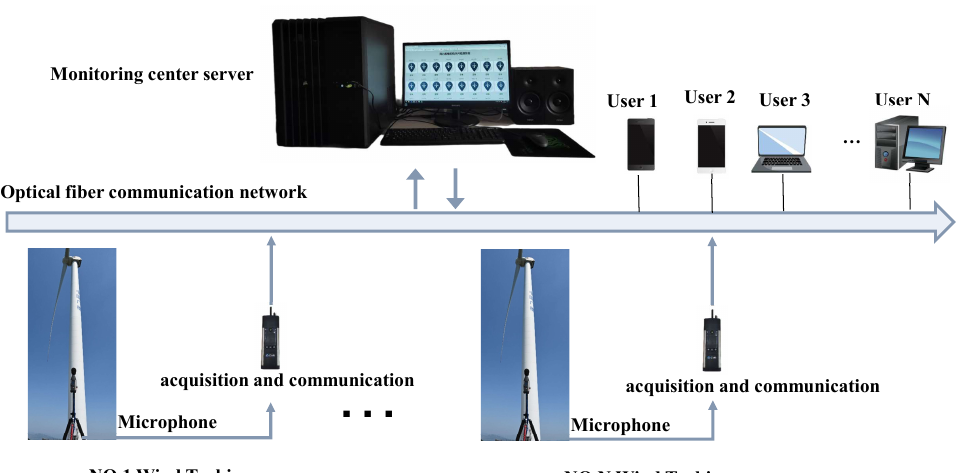
Figure 1. Wind turbine blade defect detection system.